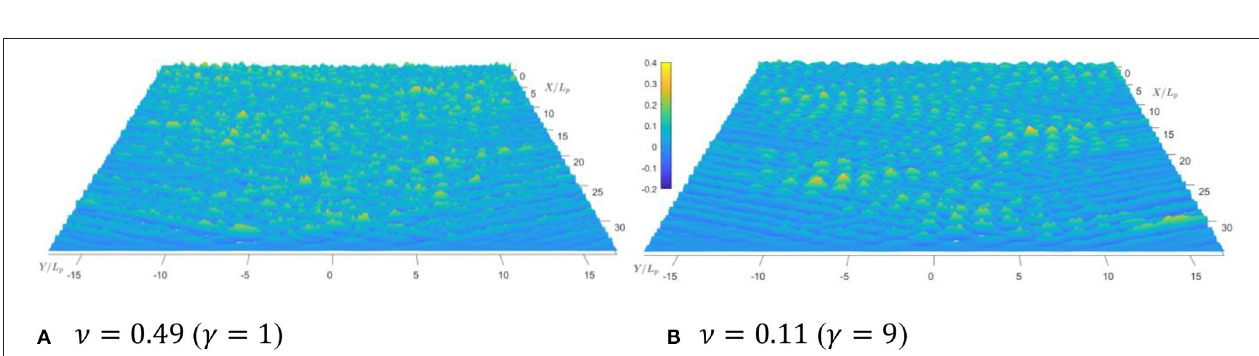
FIGURE 3 | Selected snapshot of the free surface spatial distribution in (A) broadband sea and (B) narrowband